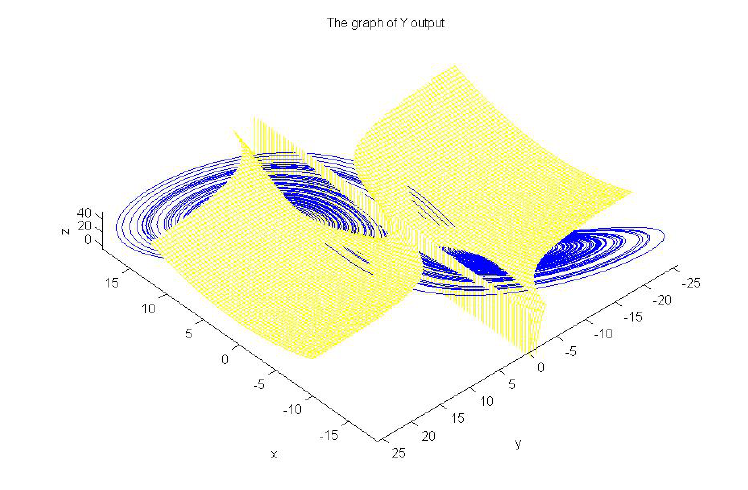
y is selected as O (yellow) when